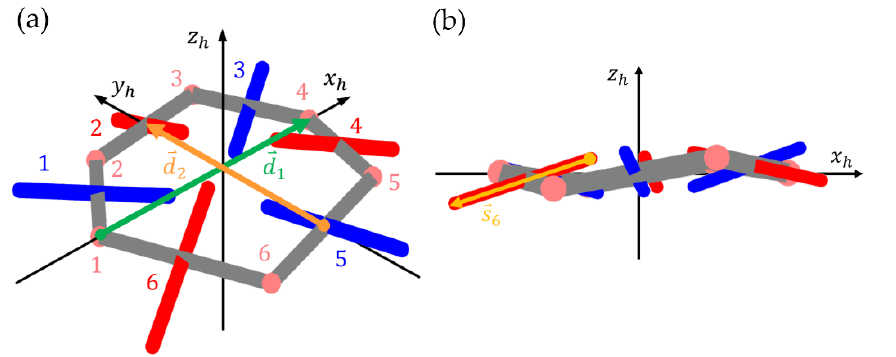
Figure 2. ( a ) A nonplanar hexagon in the coordinate system ( 𝑥 ℎ , 𝑦 ℎ and 𝑧 ℎ ) centered on the hexagon. ( b ) A side view of the hexagon. Vector 𝑑⃑ 1 connects the opposite vertices of the hexagon that lie on the 𝑥 ℎ axis, and vector 𝑑⃑ 2 , which is perpendicular to 𝑑⃑ 1 , connects the opposite midpoints of the hexagon edges and points along the 𝑦 ℎ axis. Anisotropic scatterers (blue and red lines) are positioned perpendicular to each side of a hexagon. Inside the hexagon, the polarization axis of the blue scatterers is tilted in the −𝑧 ℎ direction by an angle 𝜙 and along the +𝑧 ℎ direction for the red scatterers. Scatterers, vertices and polarization axes are numbered from 1 to 6; 𝑠⃑ 6 thus determines the polarization axis of the 6 -th scatterer.